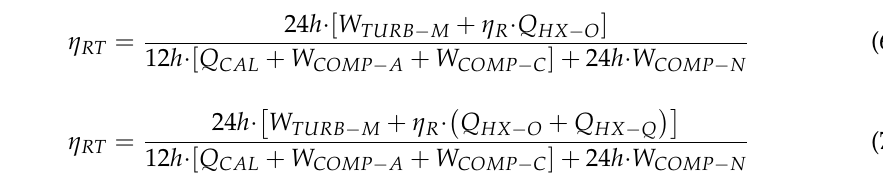
Figure 4. Process fl ow diagram for modi fi ed Con fi guration 2.